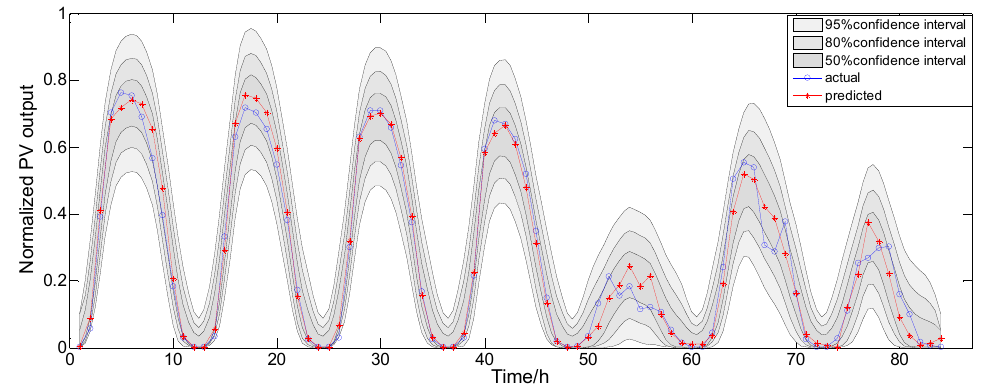
Figure 4. Point forecast and interval forecast over seven days using IMSPGP.